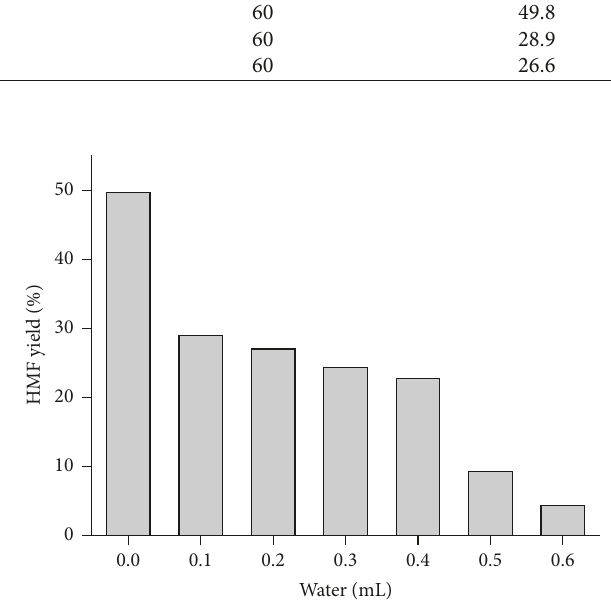
Figure 3: Effect of water added into system on the degradation of fructose. Reaction conditions: fructose lyst Table 3: Synthesis of HMF from sugars in DMSO system with S-AlMo catalysts a .